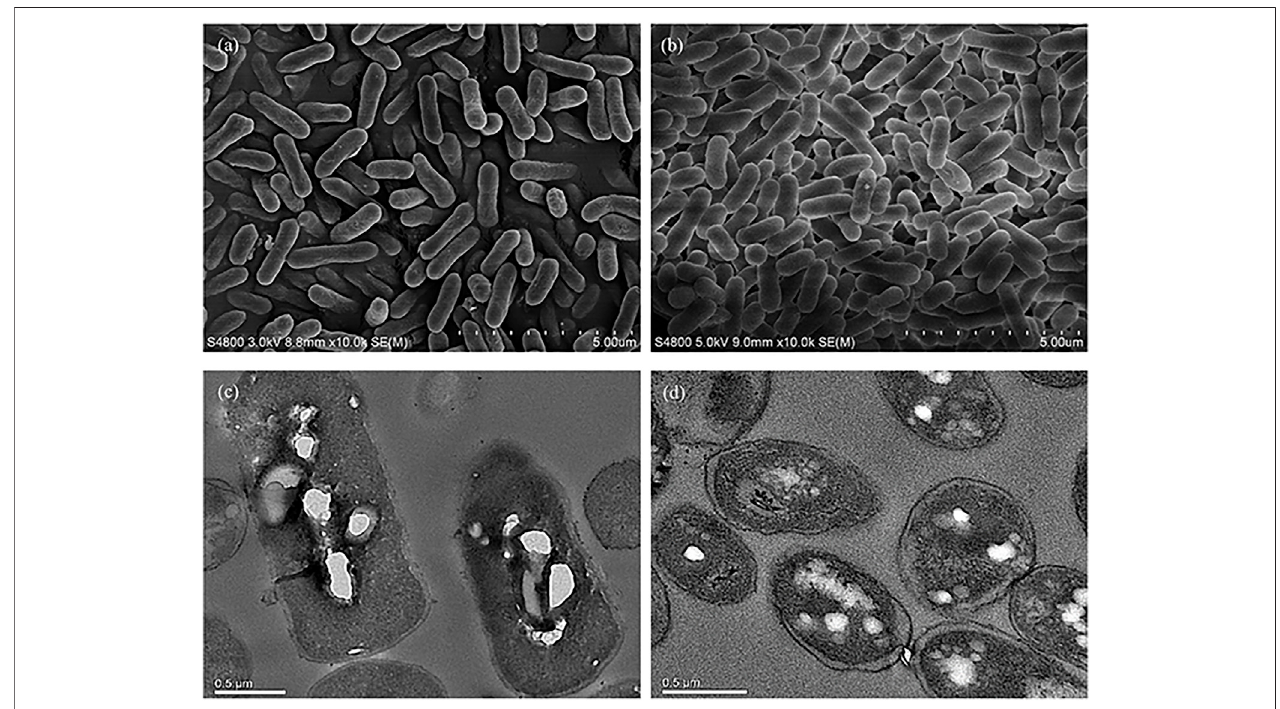
FIGURE 3 | Morphological comparison of strains with or without morphological engineering using SEM and TEM assays. (A) SEM assay of cells from the morphologically engineered strain (with the expression of sulA ). (B) SEM assay of cells from the control strain without expressing sulA . (C) TEM assay of cells from the morphologically engineered strain (with the expression of sulA ). (D) TEM assay of cells from the control strain without expressing sulA